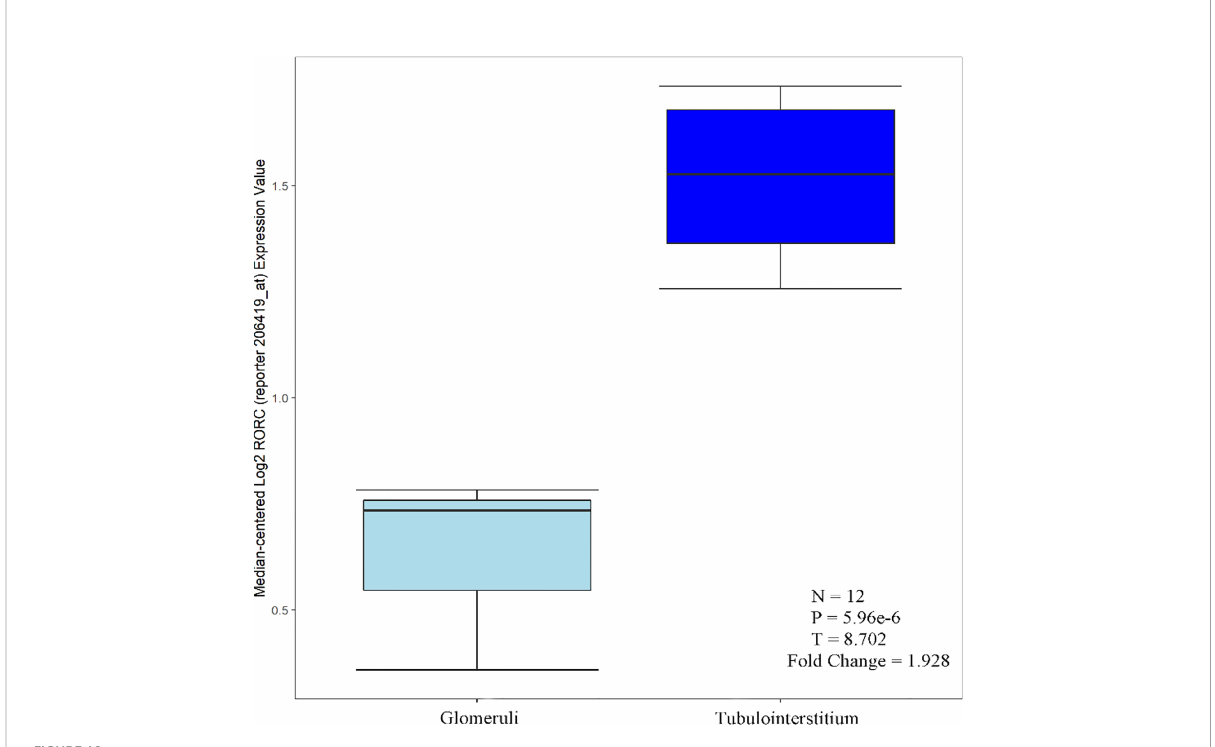
FIGURE 10 RORC over-expression in tubulointerstitium vs. glomeruli